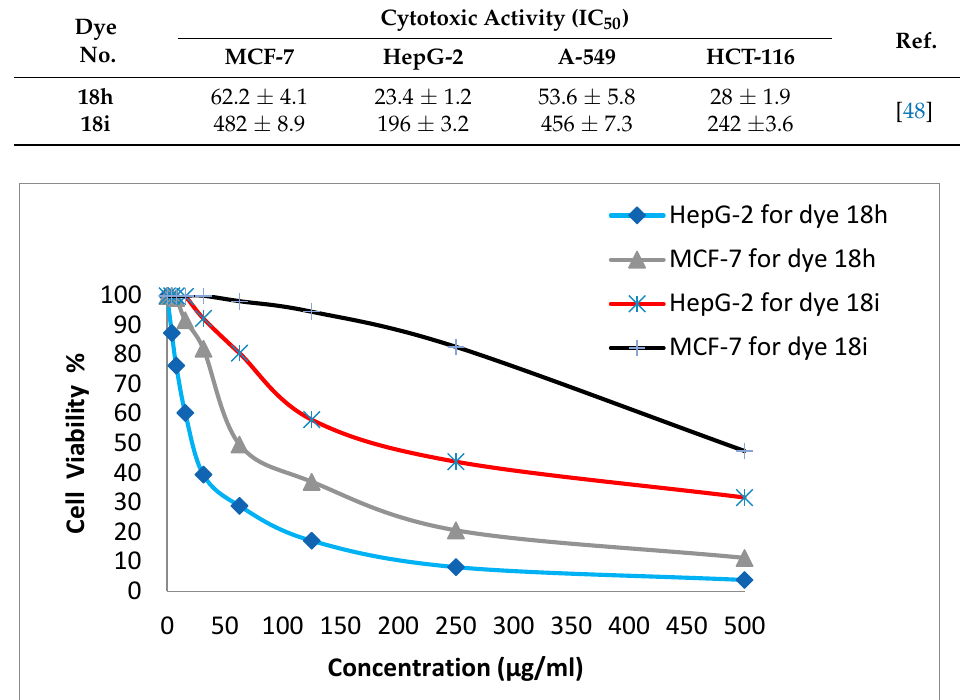
Table 4. Antitumor and antioxidant activities of disperse dyes 18h and 18i.